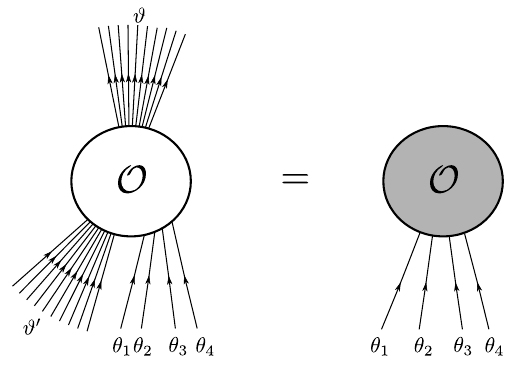
Figure 4. Graphical de(cid:12)nition of the background-dependent form factors.